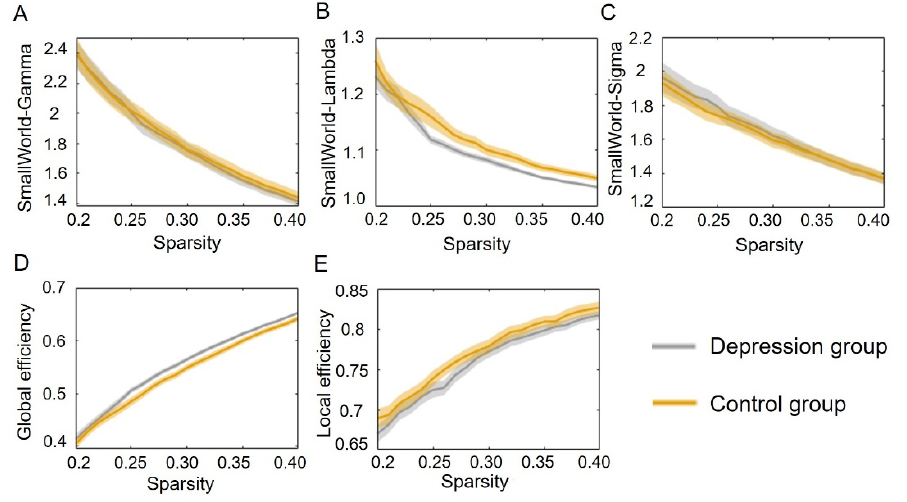
Figure 3. The global network metrices in a range of sparsity thresholds (20–40%). Panels ( A – E ) refer to small-world Gamma, small-world Lambda, small-world Sigma, global efficiency, and local efficiency as functions of sparsity thresholds. The shadows indicate standard error in all